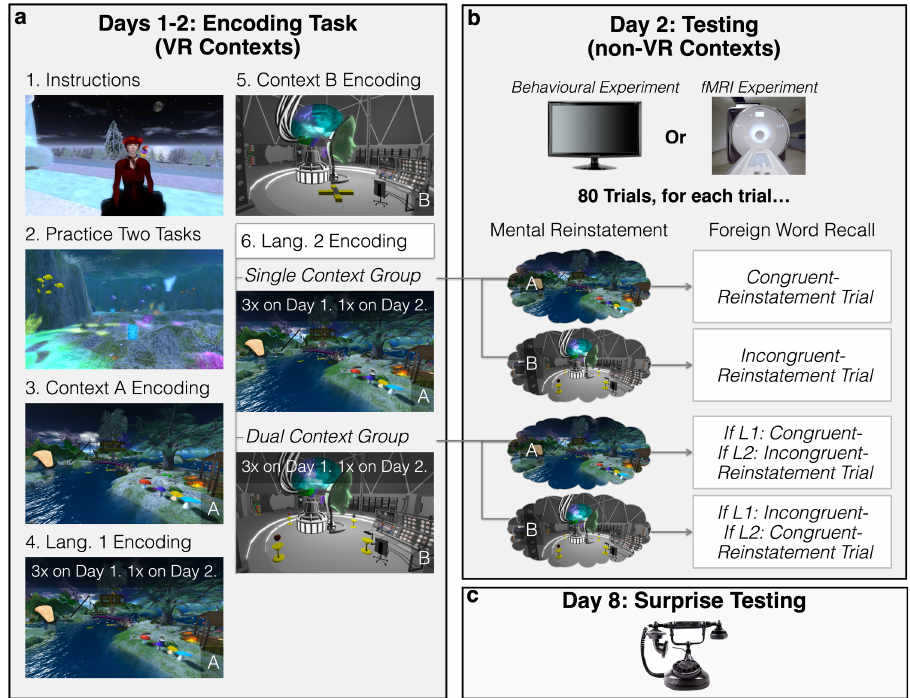
Fig. 1 Experimental design. a Encoding tasks in VR-based contexts across Days 1 and 2. a1, In an underwater practice context, participants learnt VR navigation and received tasks instructions from “ the teacher. ” a2, Task Practice (under experimenter supervision). a3, Context A Encoding. In each of Context A ’ s nine named “ rooms ” , participants stood on a location marker and performed two clock-wise rotations (720°), while imagining themselves as tourists who forgot their camera, trying to remember what it felt like to be there. a4, Language 1 Encoding. Participants remained in Context A to encode Language 1 (Rounds 1 – 3, 40 words per round). a5, Context B Encoding. a6, Language 2 Encoding (Rounds 1 – 3). All participants experienced the same procedures except for the context in which Language 2 was encoded. Single- context participants returned to Context A to encode Language 2, while dual-context participants remained in Context B to encode Language 2. On Day 2 participants performed Rounds 4 of Language 1 and Language 2 Encoding. b Day 2: short-delay recall (T4). After a short delay, participants were tested outside of the VR contexts, in the laboratory or MRI scanner. In each of 80 trials, participants fi rst mentally reinstated an auditorily cued room from one context before recalling the foreign translation of a cued word. In congruent reinstatement trials, the mentally reinstated room was the learning context of the cued word. In incongruent reinstatement trials, the mentally reinstated room was in the opposite context. c Day 8: one-week-delayed recall (T5). Participants were telephoned, ostensibly for an interview; experimenters then cued recall for all 80 foreign words. Image attribution: The VR environments and content depicted here were created by J.K.-Y.E or by Forde Davidson as commissioned by the research team, or were from the OpenSim community shared under the Creative Commons 0 License. The image of the telephone and computer monitor were modi fi ed from public domain images, and the image of the MRI scanner was provided by the UCLA Brain Mapping